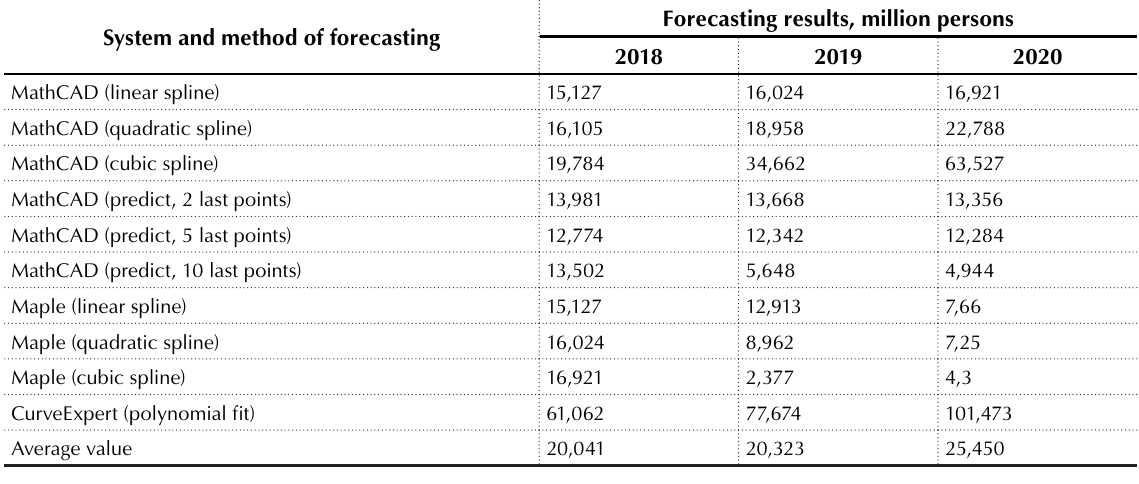
Source: Built by the authors.